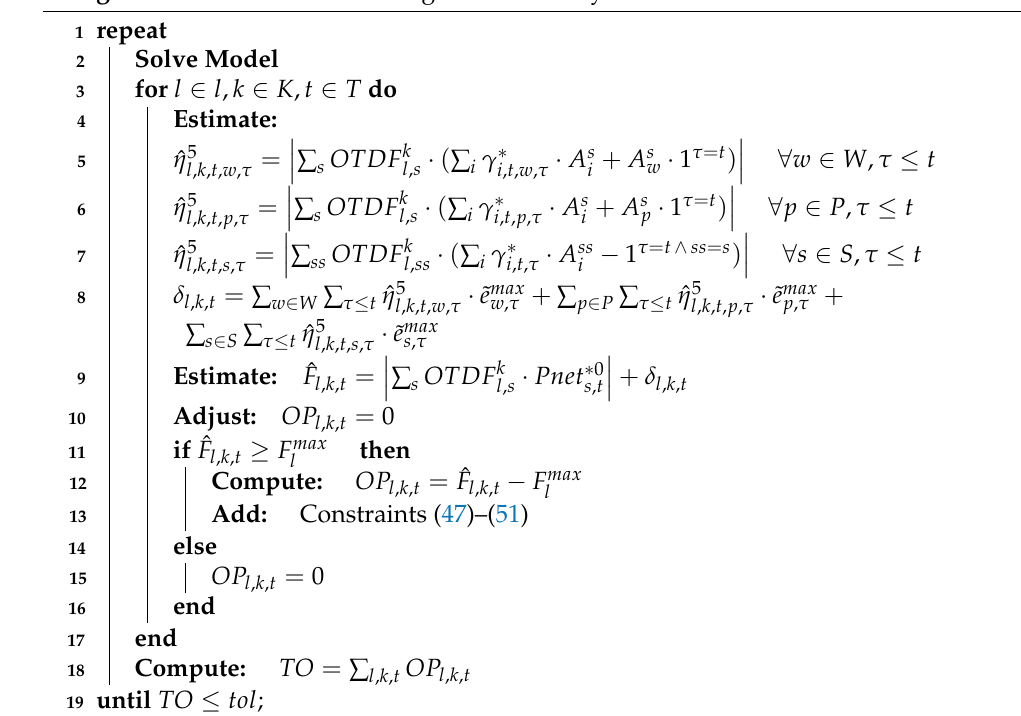
Algorithm 1: Method for Adding N − 1 Security Constraints as user cuts